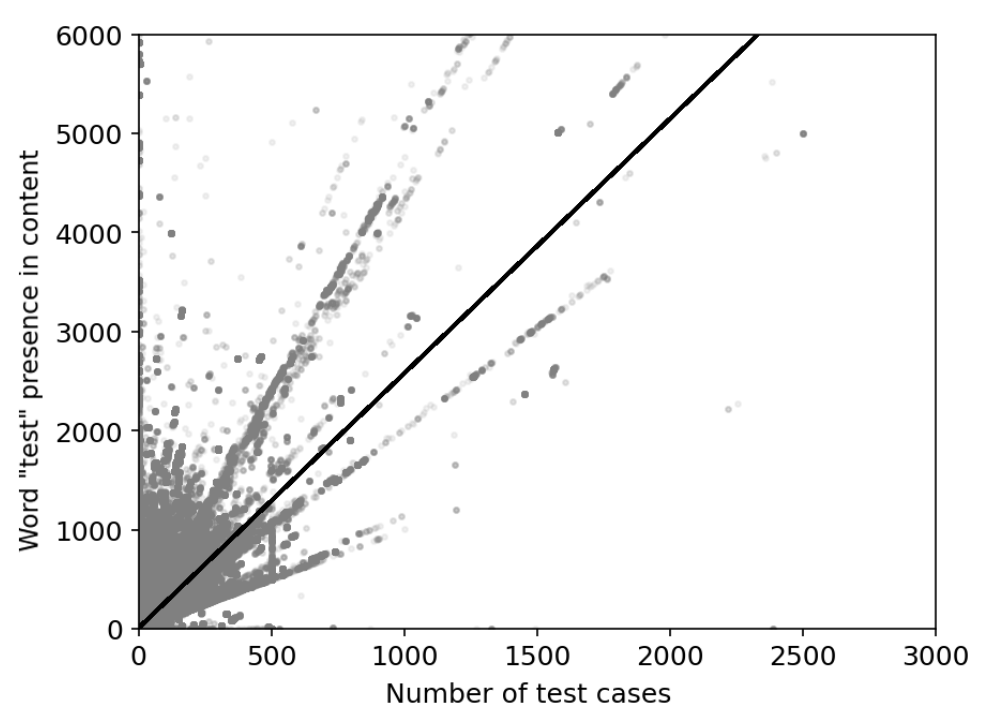
Figure 6. Correlation between the number of the “test” word occurrences in the all java files’ content of a project and the number of test cases in the particular project in all GitHub projects with Java as a primary